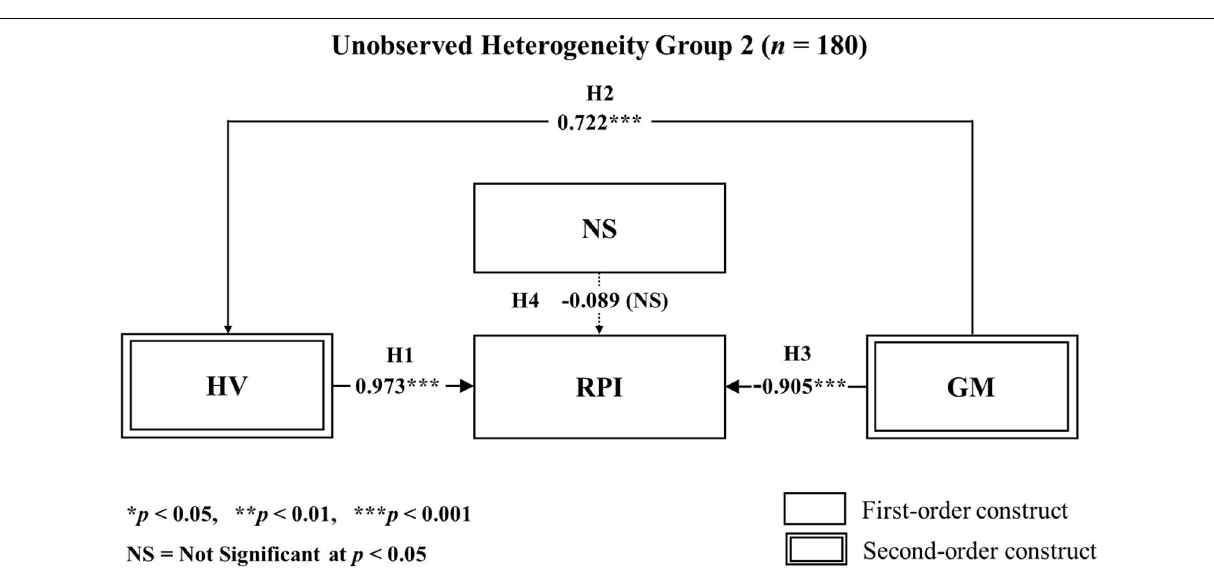
FIGURE 7 | Results of PLS-SEM hypothesis testing on segmented groups according to unobserved heterogeneity group 2 ( n = 180)